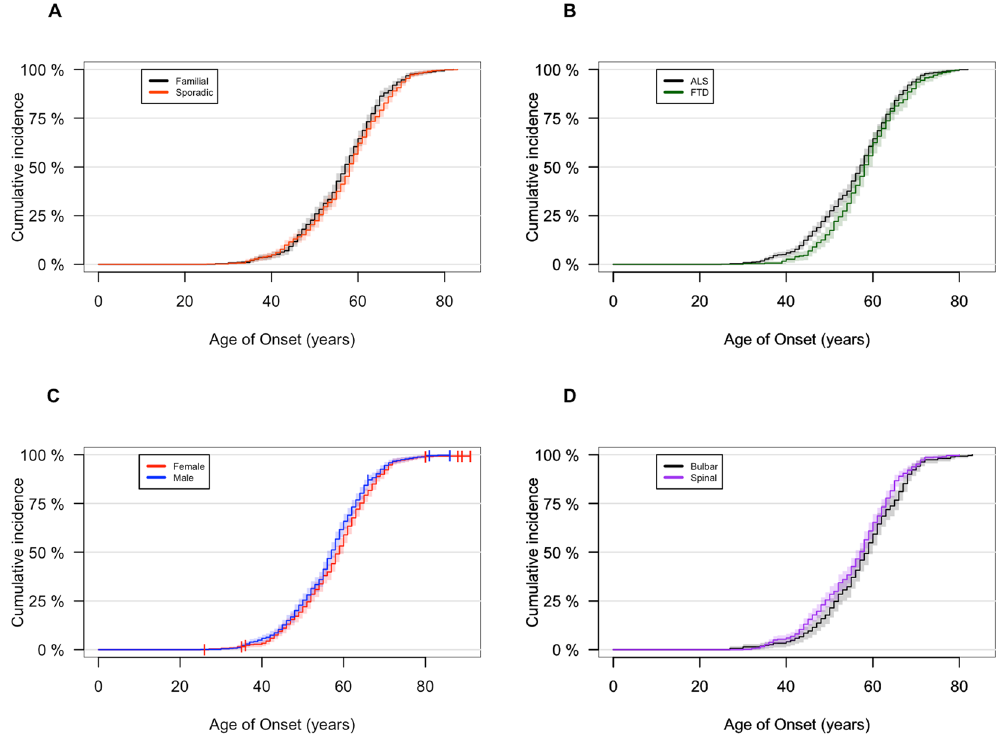
Figure 3. Age-related penetrance of the pathogenic C9orf72 repeat expansion classified by subtype. ( A ) Age- related penetrance based on familial (n = 555) and sporadic (n = 544) status; ( B ) age-related penetrance curves based on ALS (n = 734) and FTD (n = 303) clinical phenotype; ( C ) age-related penetrance curves comparing male (n = 612) and female (n = 543) cases of ALS and FTD; ( D ) age-related penetrance curves among ALS patients based on bulbar (n = 270) or spinal (n = 481) site of symptom onset. The shading represents the 95% confidence interval and censored individuals (i.e. asymptomatic) are indicated by